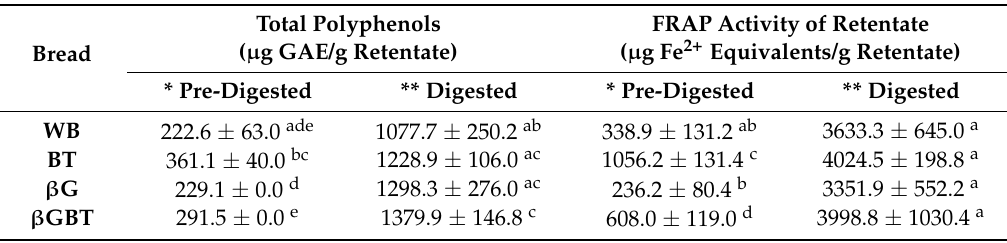
Table 2. Total polyphenol (crude) content and antioxidant potential (FRAP assay) of retentates of breads prepared with black tea and β -glucan.